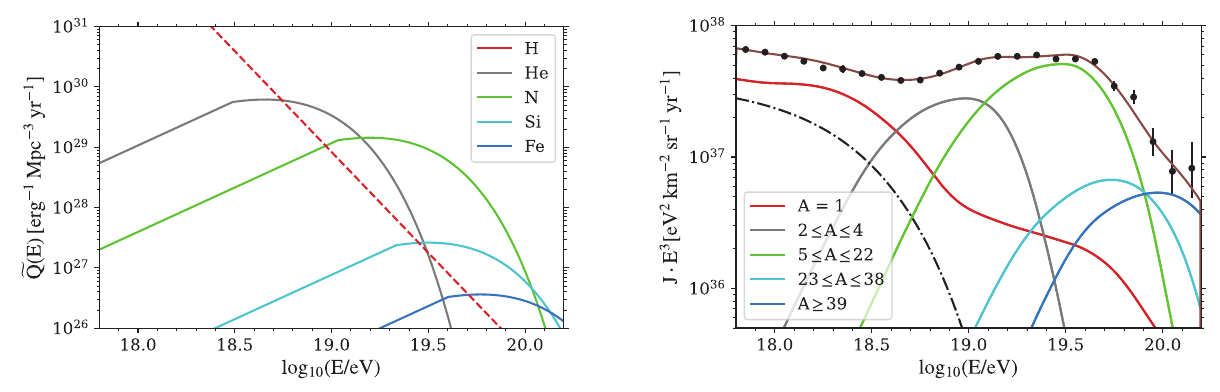
Figure 1. S cenario 1. Left: The generation rate at the extragalactic sources for each representative mass; the LE and HE contributions are shown as dashed and solid lines, respectively. Right: The corresponding Galactic (dot-dashed line) and extragalactic (grouped according to mass number) contributions to the energy spectrum at the top of atmosphere.